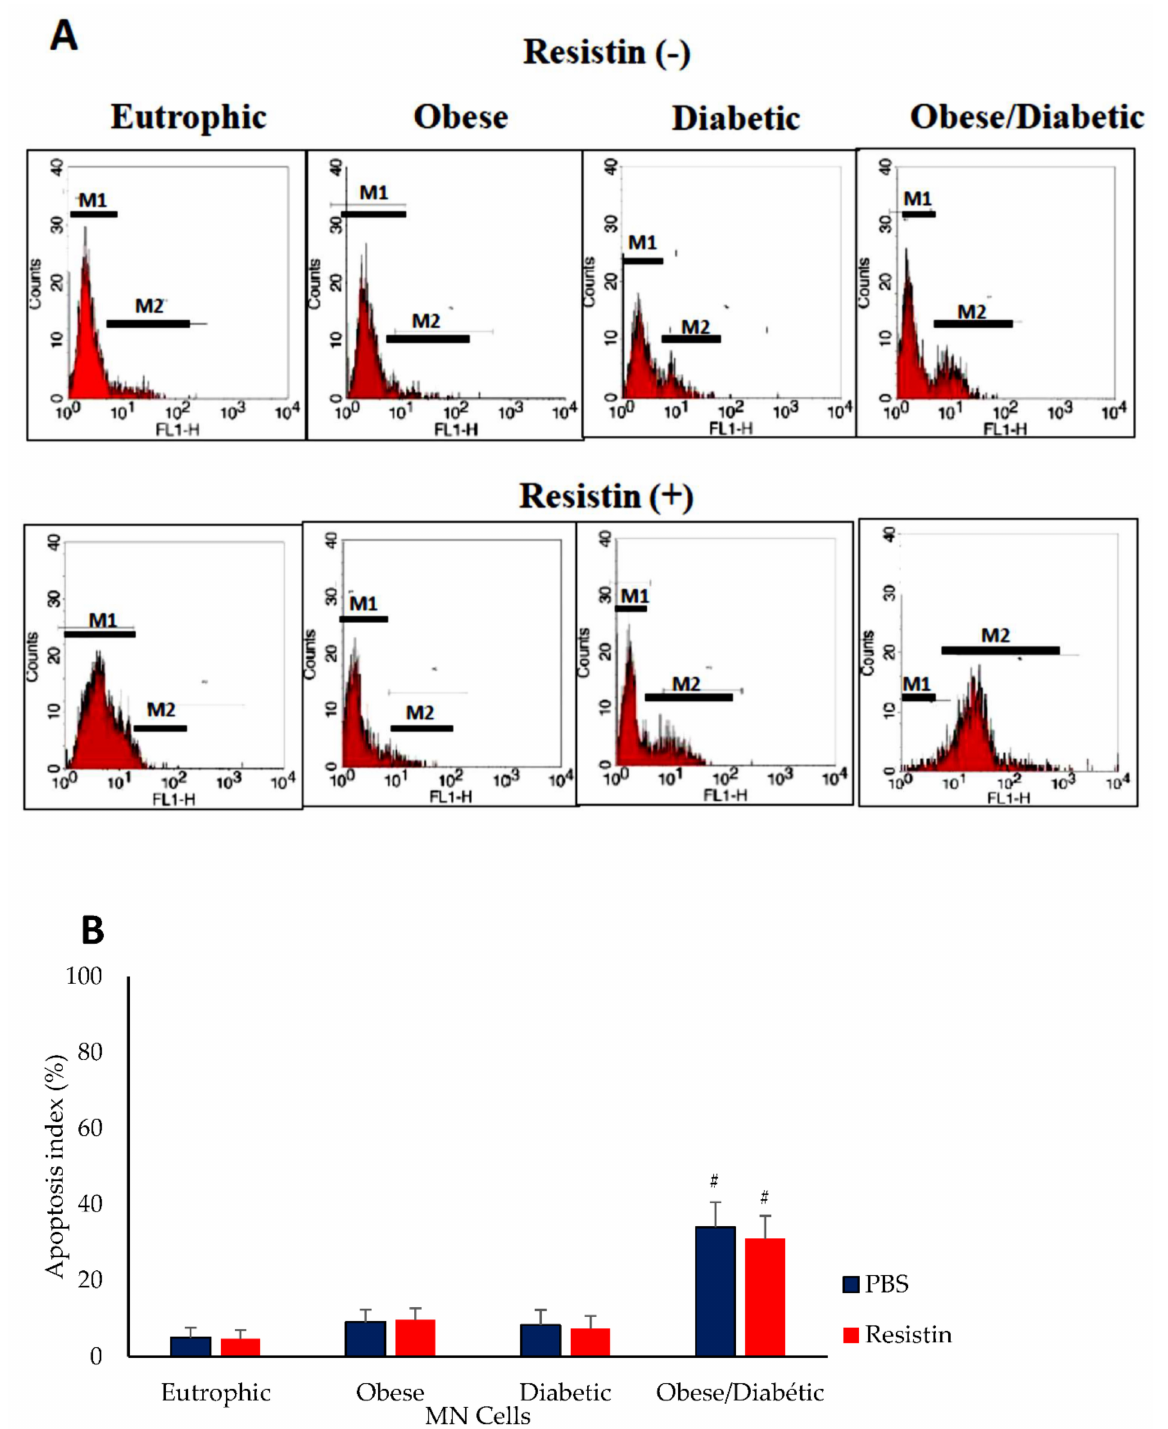
Figure 1. Apoptosis index (%) of colostrum mononuclear (MN) cells treated with resistin or left untreated from mothers with different glycemic and nutritional status. ( A ) Cells were labeled with fluorescein isothiocyanate deoxyuridine triphosphates (FITC-dUTP). The presence of apoptotic cells was demonstrated by increased fluorescence intensity (M2 gate). ( B ) Cell apoptosis index. Data were expressed as means and standard errors of eight MN cells from different individuals in each group (ANOVA, p < 0.05). # Significant difference between groups considering the same